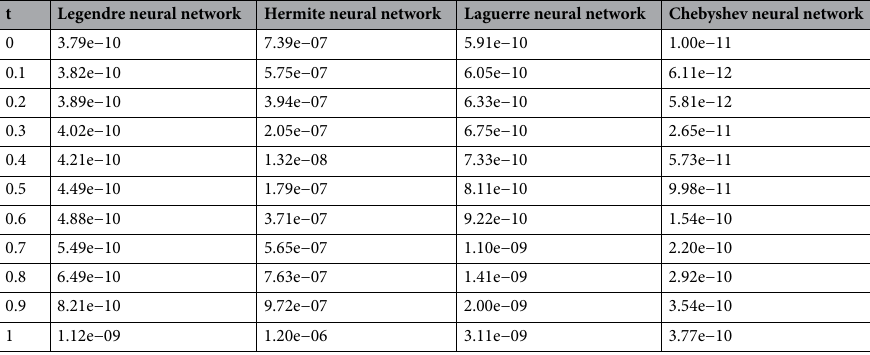
Table 8. The relative error for Example 6.4 with different orthogonal neural networks.